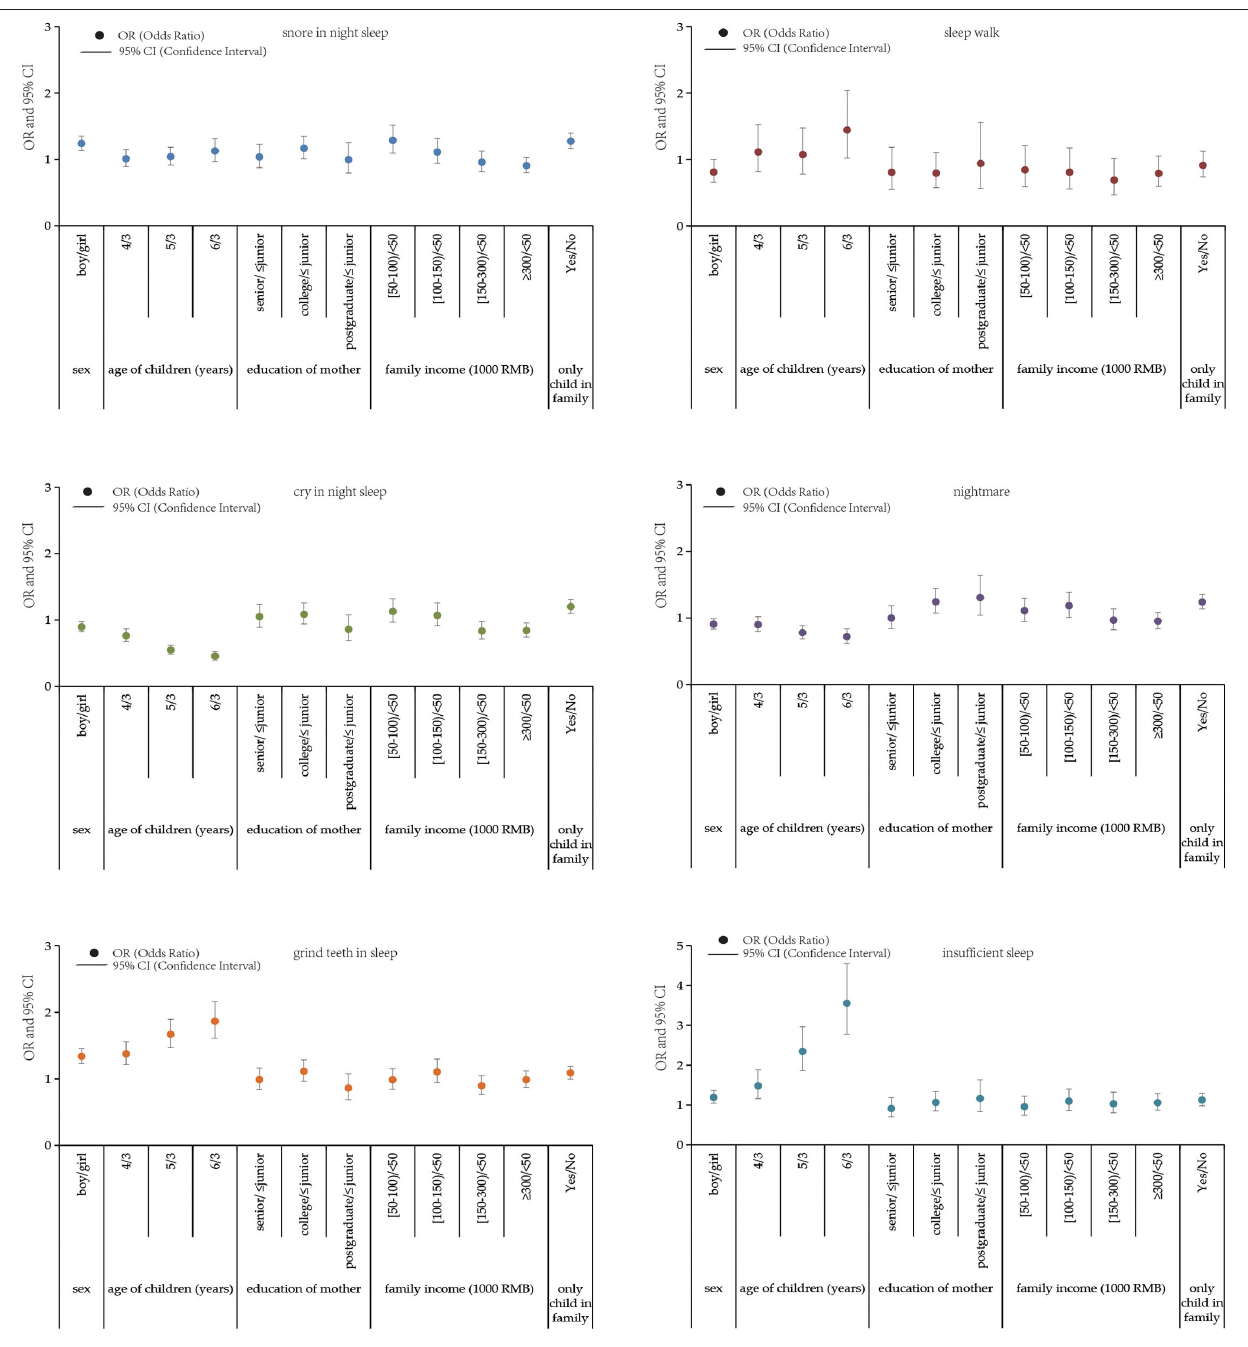
of mother was positively associated with the prevalence of insufficient sleep, sleepwalk, and nightmare in children, and family income was negatively associated with the prevalence of all 6 sleep problems in children aged 3–6 years; and (3) except